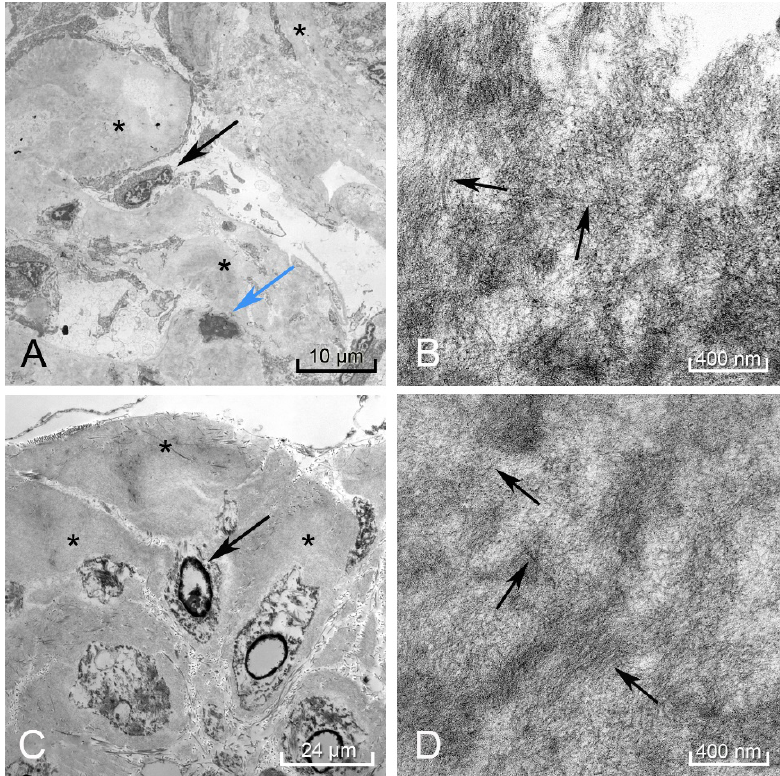
Figure 5. Electron microscopy of the kidney showed amorphous deposits within the mesangium and membranes of the capillary loops in the glomeruli (black arrow podocyte, blue arrow mesangial cell, black * amyloid deposit) ( A ). Higher magnification revealed these to be amyloid fibrils arranged in a haphazard pattern (black arrows perpendicular to fibril direction) ( B ). The rectum showed these same amyloid deposits (black *) surrounding the smooth muscle myocytes (black arrow) ( C ), demonstrating a similar pattern to the fibrils found in the kidney (black arrows perpendicular to fibril direction) ( D ). Autolytic changes were appreciated in the disintegrating nuclei of the mesangial cell and rectal myocytes.